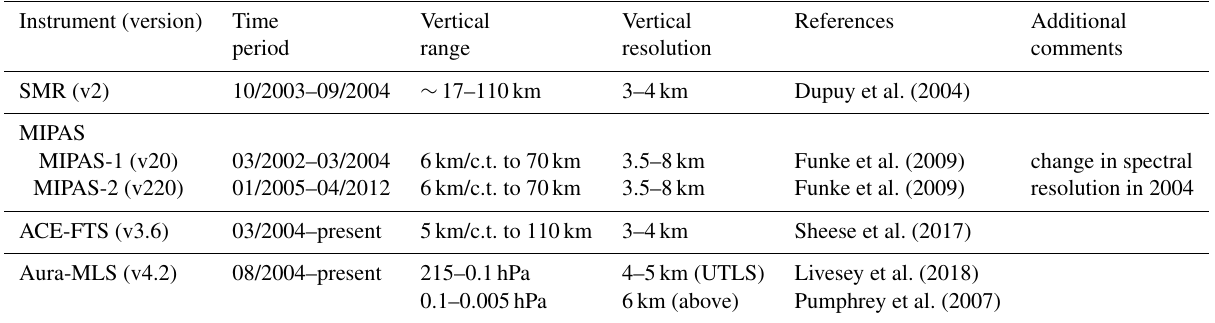
Table 12. Time period, vertical range, vertical resolution, references, and other comments for CO measurements. Note that c.t. refers to cloud top in this